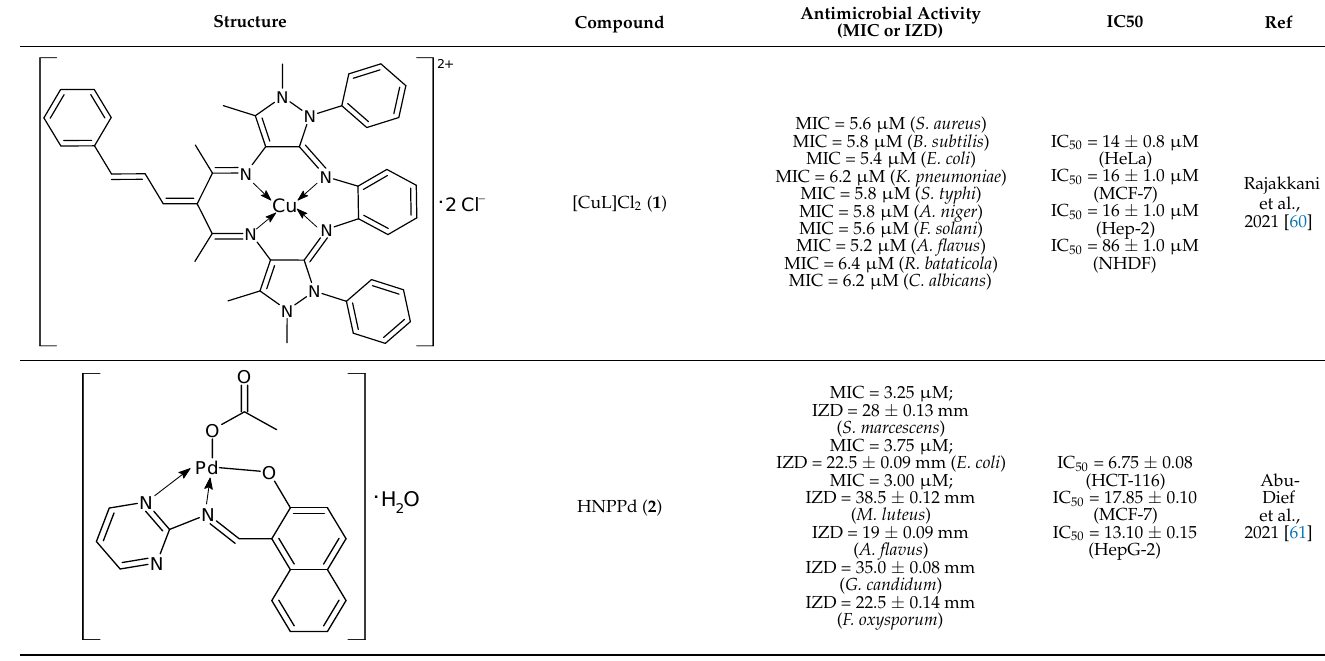
Table 1. SBs mononuclear metal complexes with antimicrobial and antiproliferative activities. Structure Compound